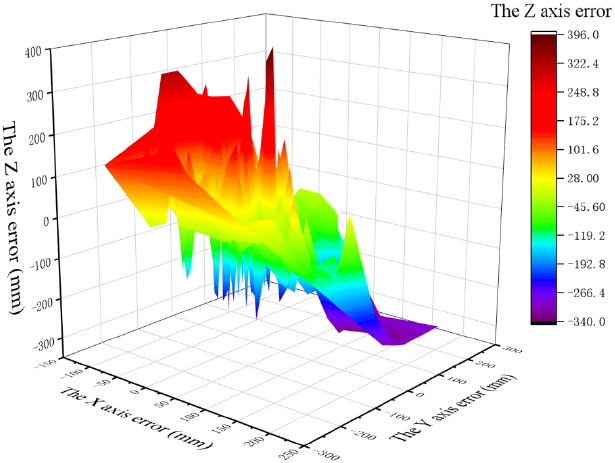
Figure 16. 3D ( X , Y , Z ) accuracy of normal data sets based on traditional